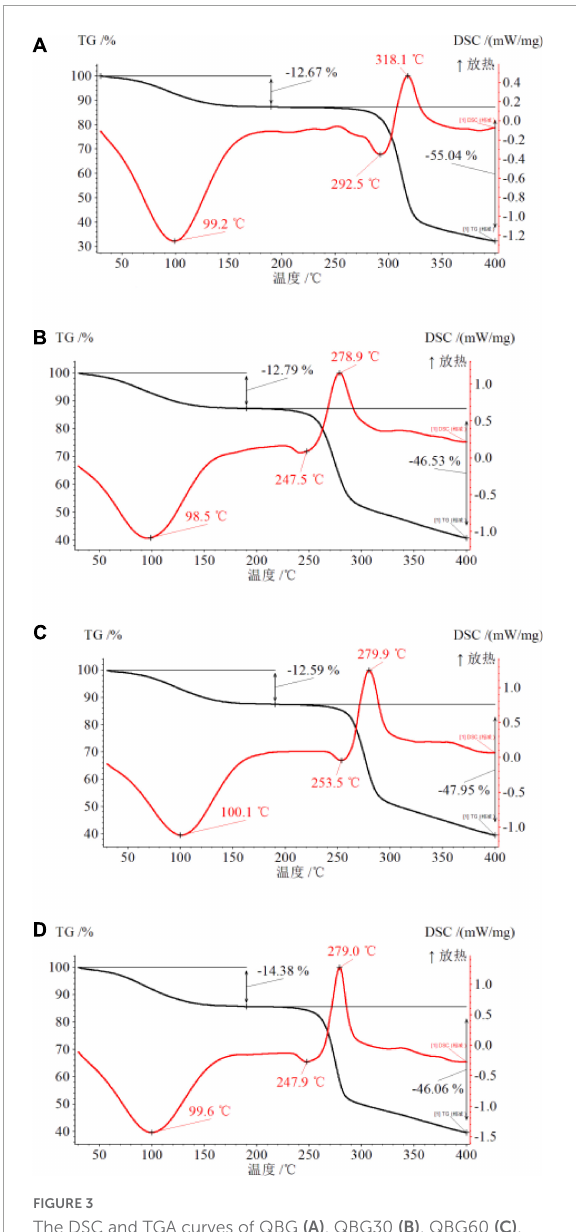
FIGURE3 The DSC and TGA curves of QBG (A) , QBG30 (B) , QBG60 (C) , and QBG90 (D)